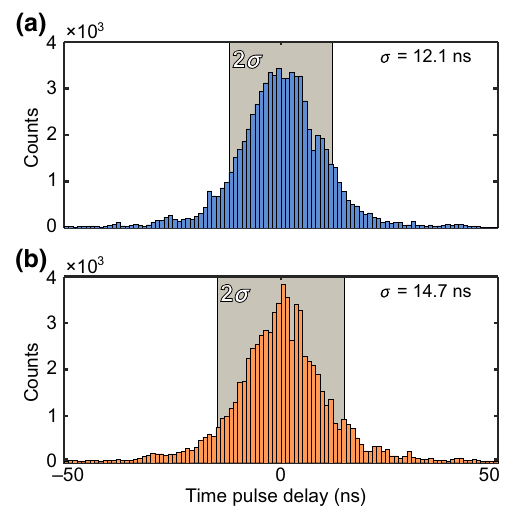
FIG. 3. Histogram of relative delays between time pulses from two GPS receivers. (a) Alice and Bob. (b) Charlie and Alice.